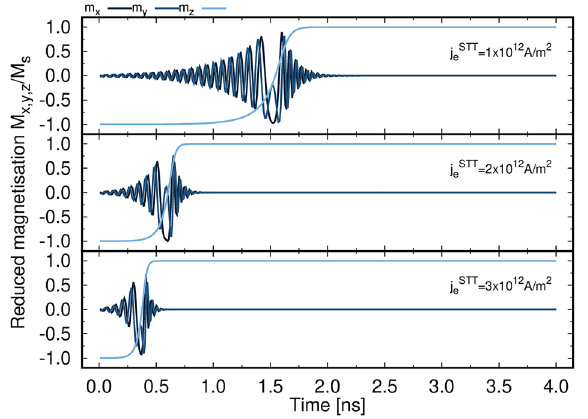
Figure 2. Time evolution of the magnetisation components of a 20 nm diameter MTJ for j STT e 1 × 10 12 , 2 × 10 12 and3 × 10 12 Am − 2